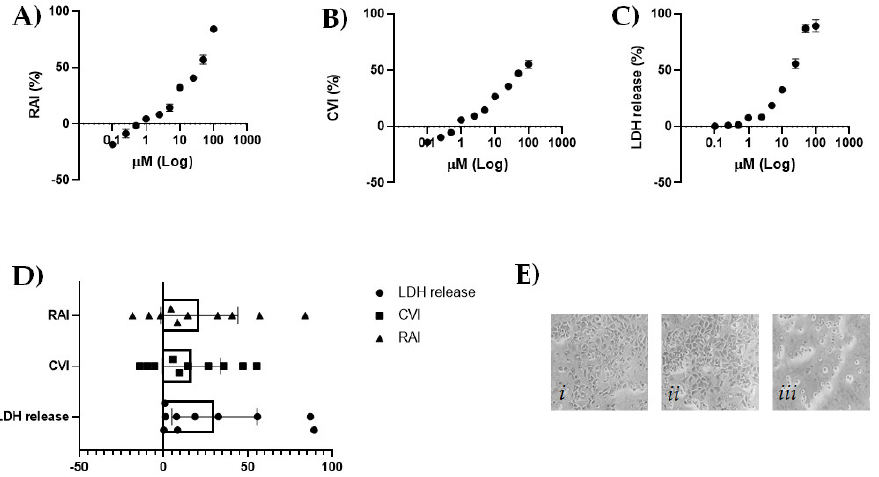
Figure 2. ( A ) Redox mitochondrial activity inhibition (%) by means of MTT data; ( B ) cell viability inhibition (%) by SRB assay data; ( C ) LDH release (%) by LDH assay data. Values are the mean ± SD of two independent experiments. Six replicates were performed in each experiment. ( D ) Scatter plot of data from the three different cytotoxicity assays with a representation of their 95% confidence limits using Graphpad Prism 8 software (Graphpad Software, La Jolla, CA, USA). ( E ) Representative images, acquired by Inverted Phase Contrast Brightfield Zeiss Primo Vert Microscope, of ( i ) untreated HaCaT cells; ( ii ) CBDA 2.5 μM treated HaCaT cells; ( iii ) CBDA 25 μM treated HaCaT cells.